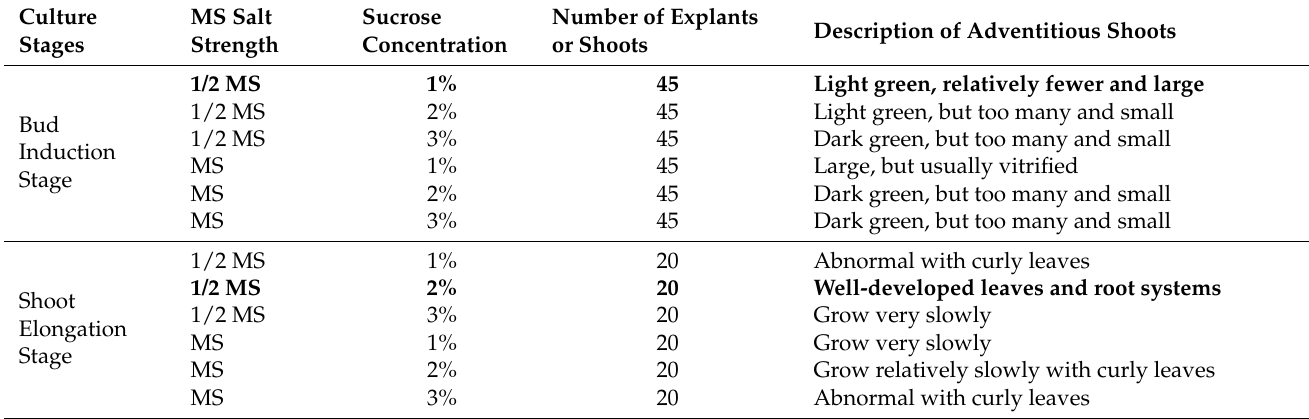
Figure 3. Effect of placing orientation of leaf explants on shoot regeneration. ( a ) The adaxial side of leaf explants was placed upward. ( b ) The abaxial side of leaf explants was placed upward. ( c ) The adaxial view of explants cultured with abaxial surface upward. ( d ) A seedling grown on the medium without 6-BA and NAA. ( e ) A seedling grown on the medium containing 0.5 mg/L 6-BA and 0.1 mg/L NAA. Scale bars: 0.5 cm. Table 3. Determination of the optimal media for adventitious shoot induction and shoot elongation.